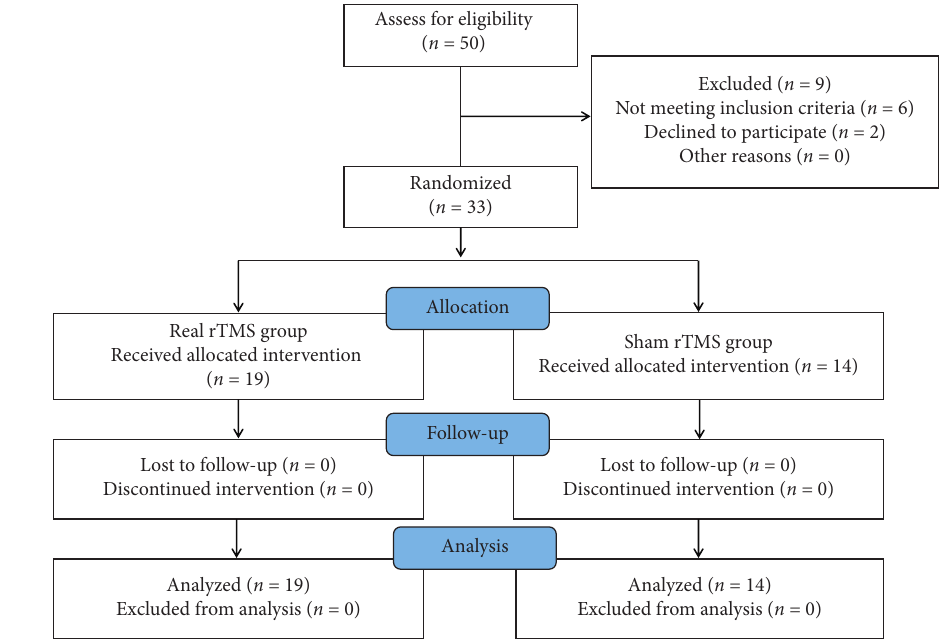
Figure 1: Study flow diagram.